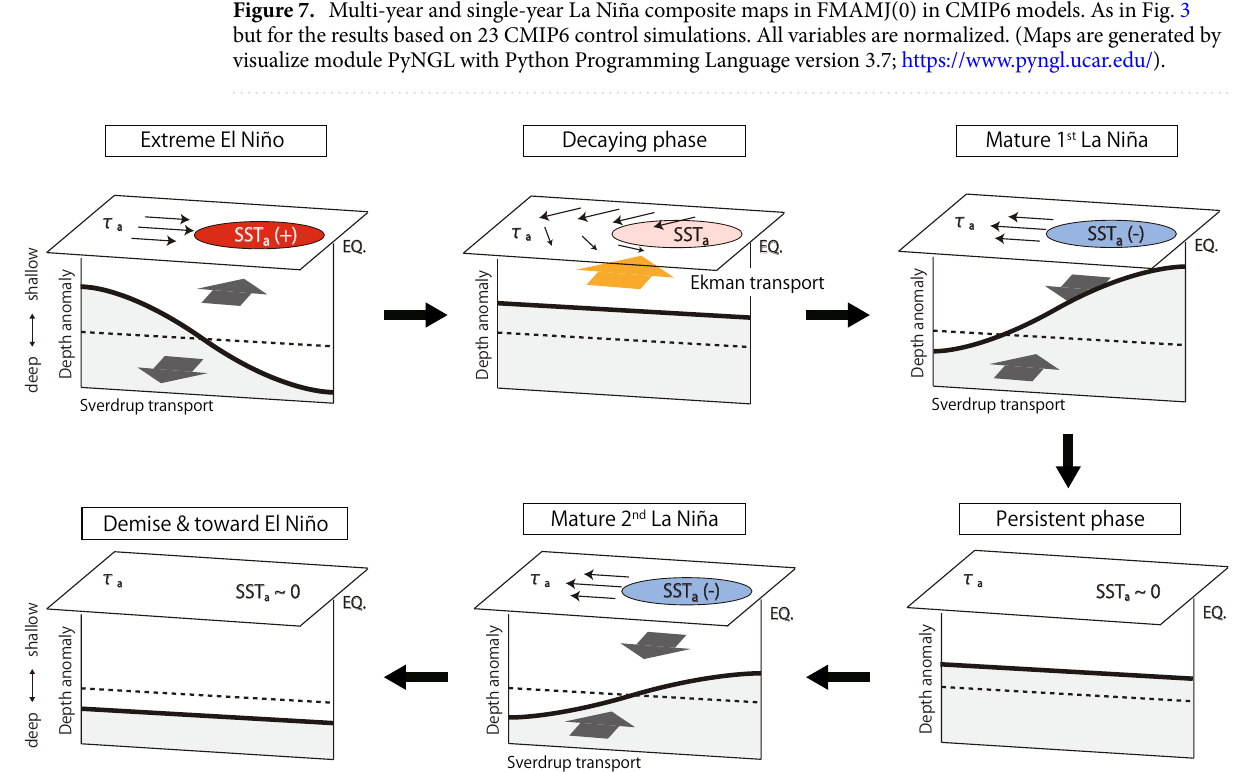
Figure 8. Schematic representation of multi-year La Niña triggered by strong El Niño. The time evolution is clockwise. Thick line indicates the thermocline depth anomaly from zero line (dashed line). Horizontal vector represents the surface wind stress anomaly. Red/blue shadings are the SST anomaly. Thick meridional arrows represent the geostrophic (gray) and Ekman (orange) heat transports. Figure is modified from a schematic diagram of the recharge oscillator 10